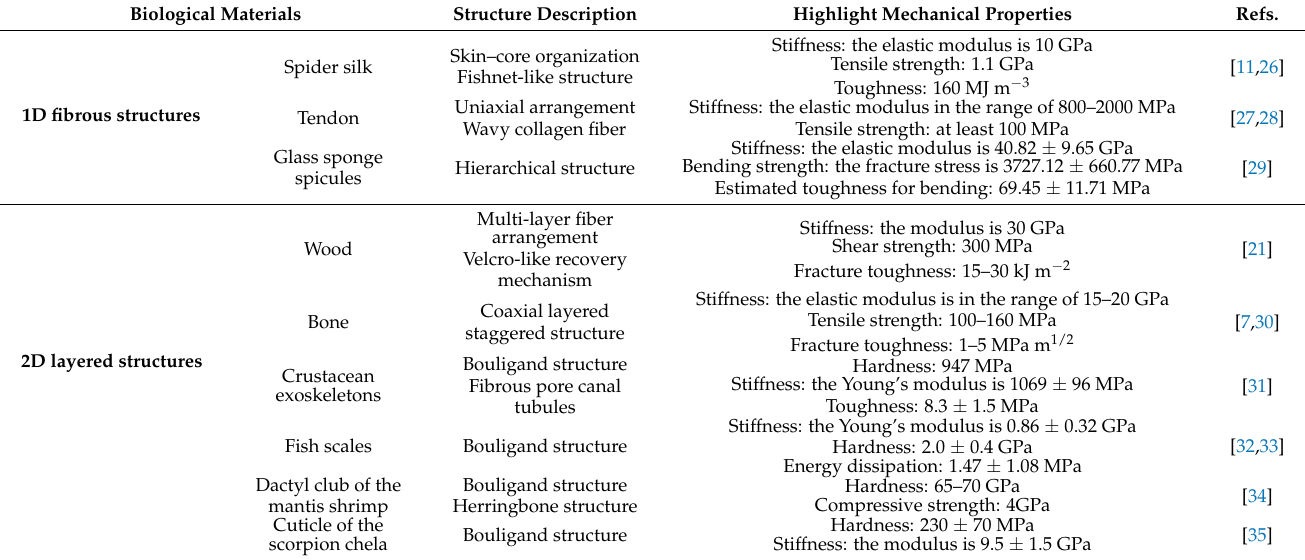
Table 1. Multi-dimensional structures of typical biological models in nature. Biological Materials Structure Description Highlight Mechanical Properties